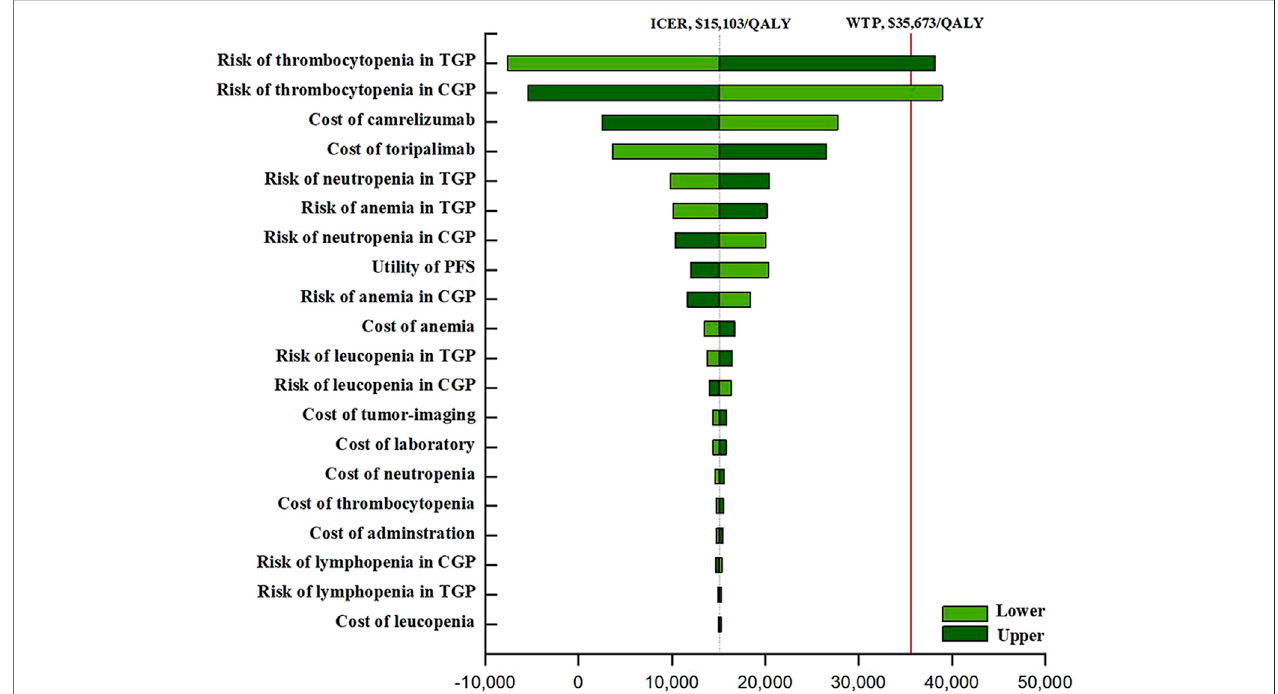
FIGURE 1 | The one-way sensitivity analyses. Abbreviation: TGP, toripalimab plus gemcitabine and cisplatin; CGP, camrelizumab plus gemcitabine and cisplatin; GP, gemcitabine plus cisplatin; PFS, progression-free survival; BSC, best supportive care.